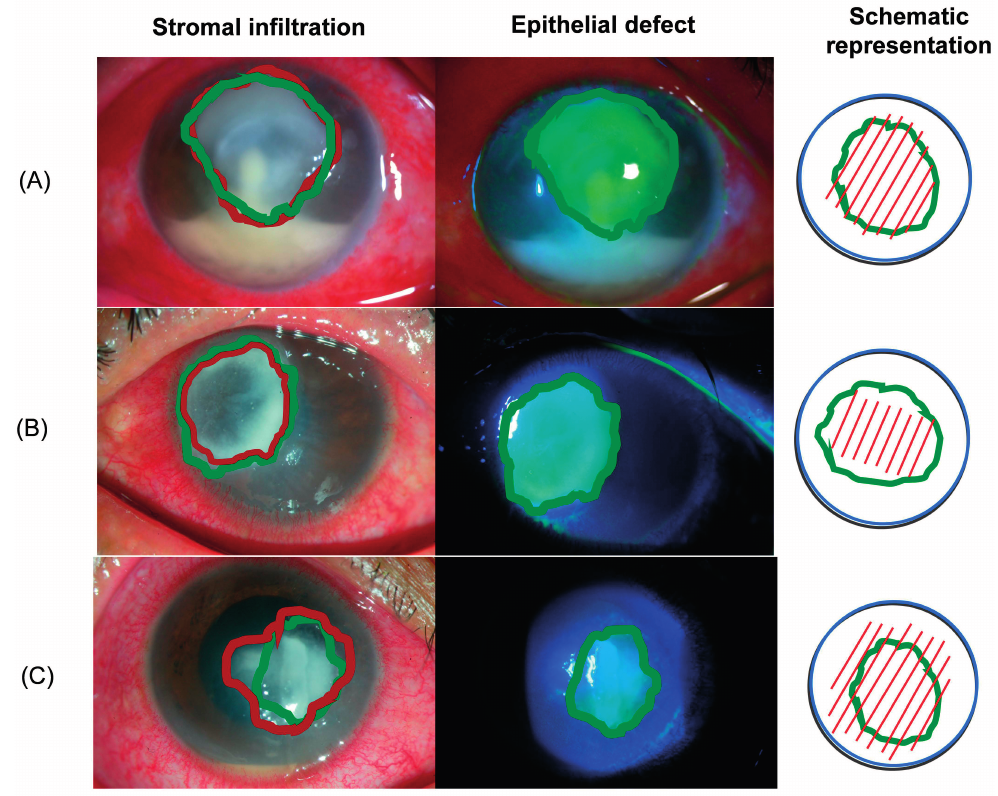
Figure 1. Representative clinical photographs of human microbial keratitis, Patient eye with Gram-positive bacterial keratitis ( A ); important conjunctival hyperemia with superior corneal infiltration (red) similar in size to the epithelial defect (green), a central fountain-like deposition linked to hypopyon, and creamy reaction in the anterior chamber. The causative microorganism was S. pneumoniae ; Patient eye with gram-negative bacterial keratitis ( B ); stromal infiltration (red) apparently surrounded at the edge by the epithelial defect (green). The causative agent was Pseudomonas spp.; Patient eye with fungal keratitis; ( C ) a central epithelial defect (green) is seen with stromal infiltration, (red) and a typical feathery appearance surrounding the lesion. No lysis is observed, and the hypopyon has a white-creamy appearance. The causative agent was Fusarium spp. Schematic representation according with the size of the epithelial defect (green) and stromal infiltration (red) is proposed in the third column. Epithelial defects were observed under slit-lamp illumination with cobalt blue filter. See also Table